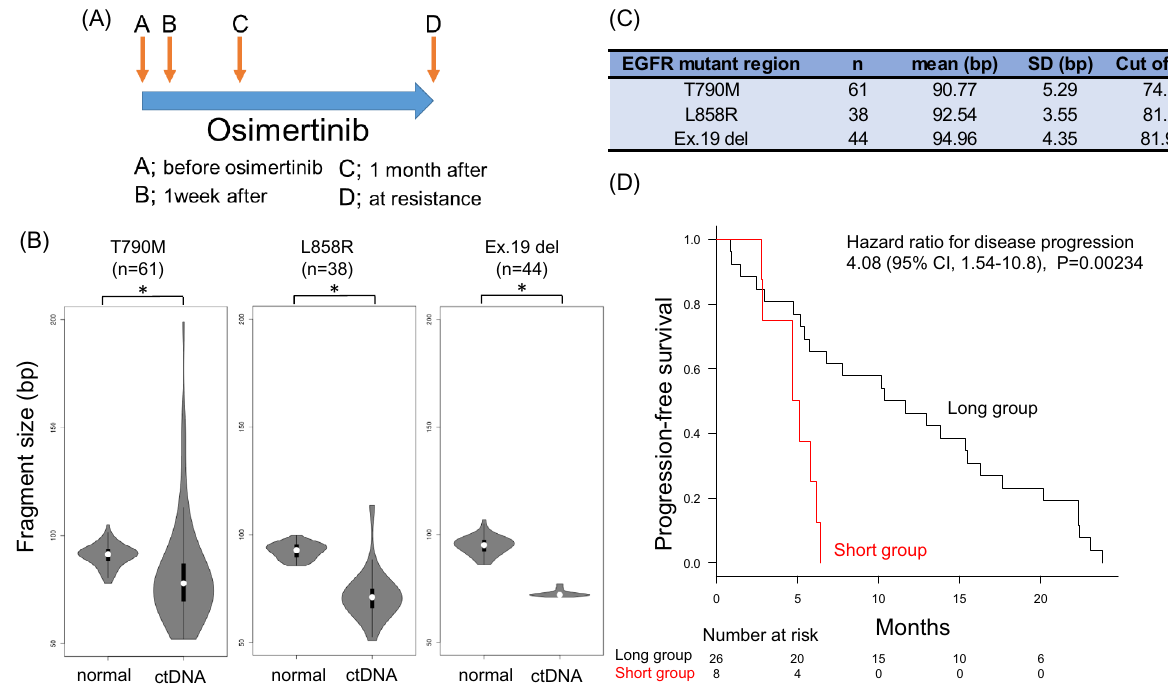
Figure 1. ( A ) Schematic representation of the research protocol. Peripheral blood was collected before administration of osimertinib (point A), one week after administration (point B), one month after administration (point C), and when osimertinib resistance was identified (point D). ( B ) Violin plot of EGFR wild-type and mutated ctDNA fragmentations. White circles ( 〇 ) indicate median levels. The plots represent individual EGFR-mutated alleles and the respective number of cases; * p < 0.05. ( C ) The median, standard deviation (SD), and cut-off values of each fragment size of EGFR T790M, L858R, and Ex.19 deletion alleles. ( D ) Kaplan–Meier plot of PFS for osimertinib treatment. Comparison of PFS for EGFR -mutated patients with the shorter EGFR -mutated allele fraction (red line) vs. others (black line); HR for the long group: 4.08 (95% CI, 1.54–10.8; p <